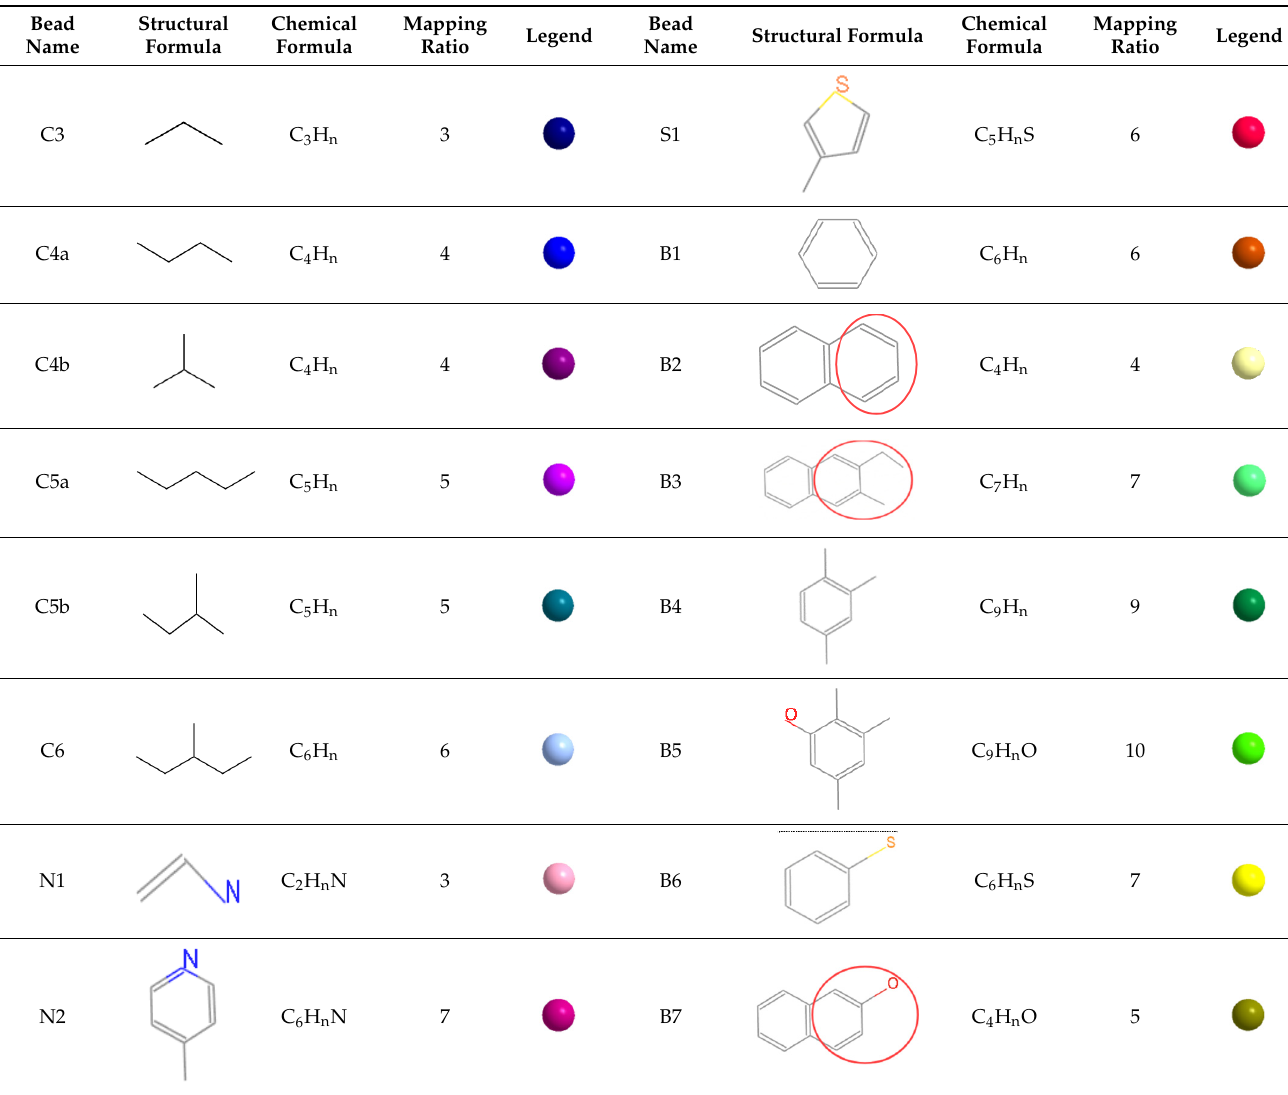
Table 3. Beads of bitumen CG molecular model.